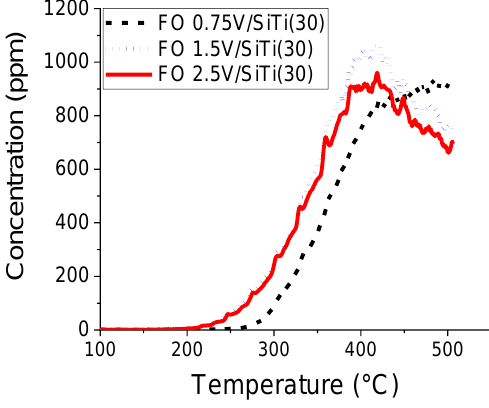
Figure 8. Formation of formaldehyde over silica–titania (V/SiTi(30)) catalysts with different V